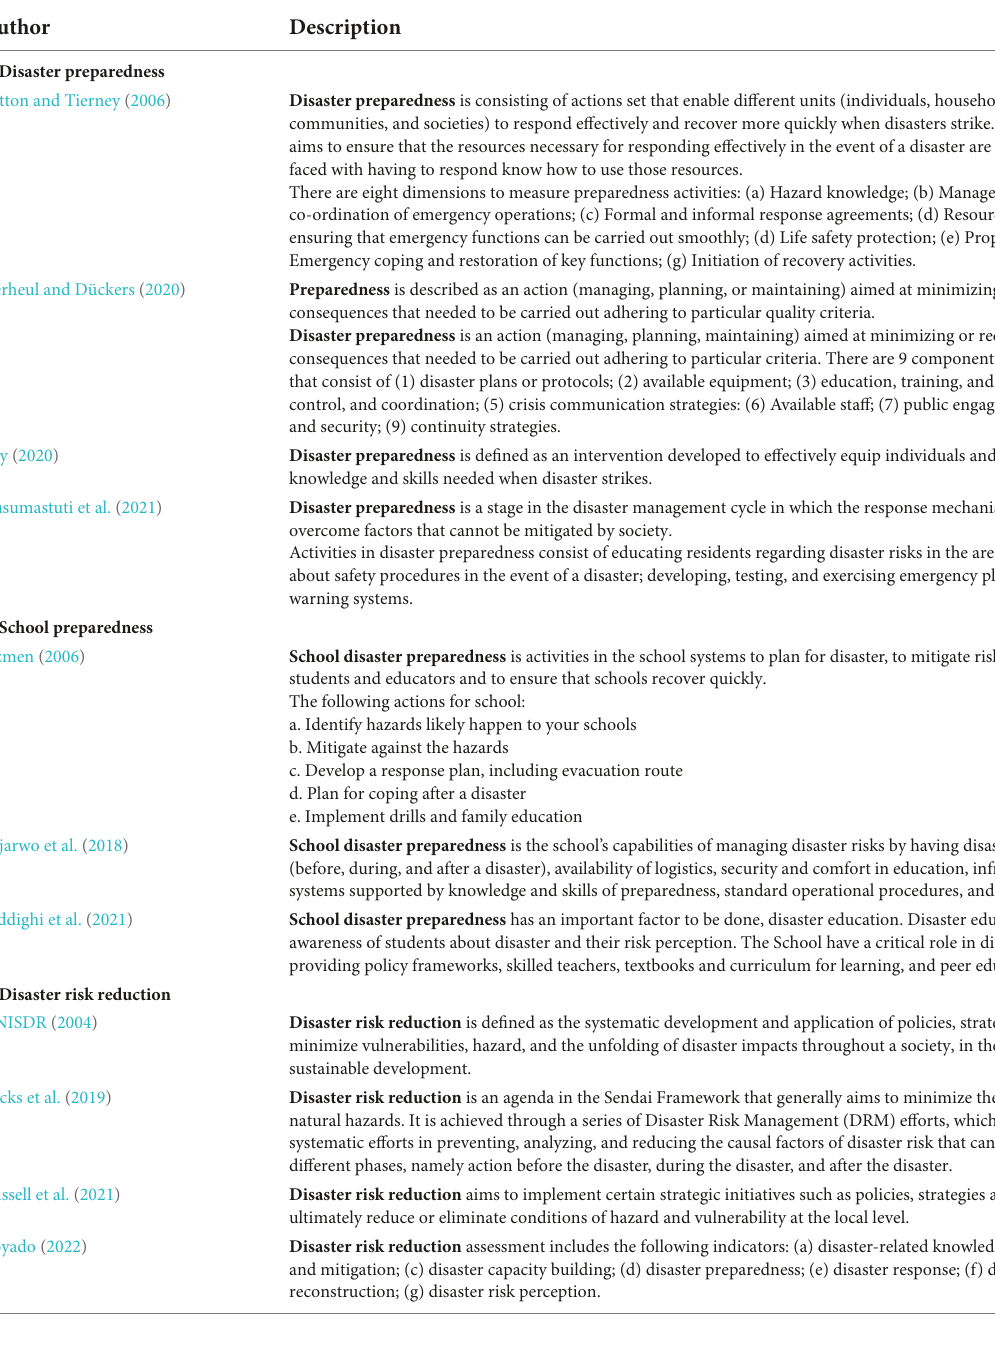
TABLE 1 Explanation for each concept from several